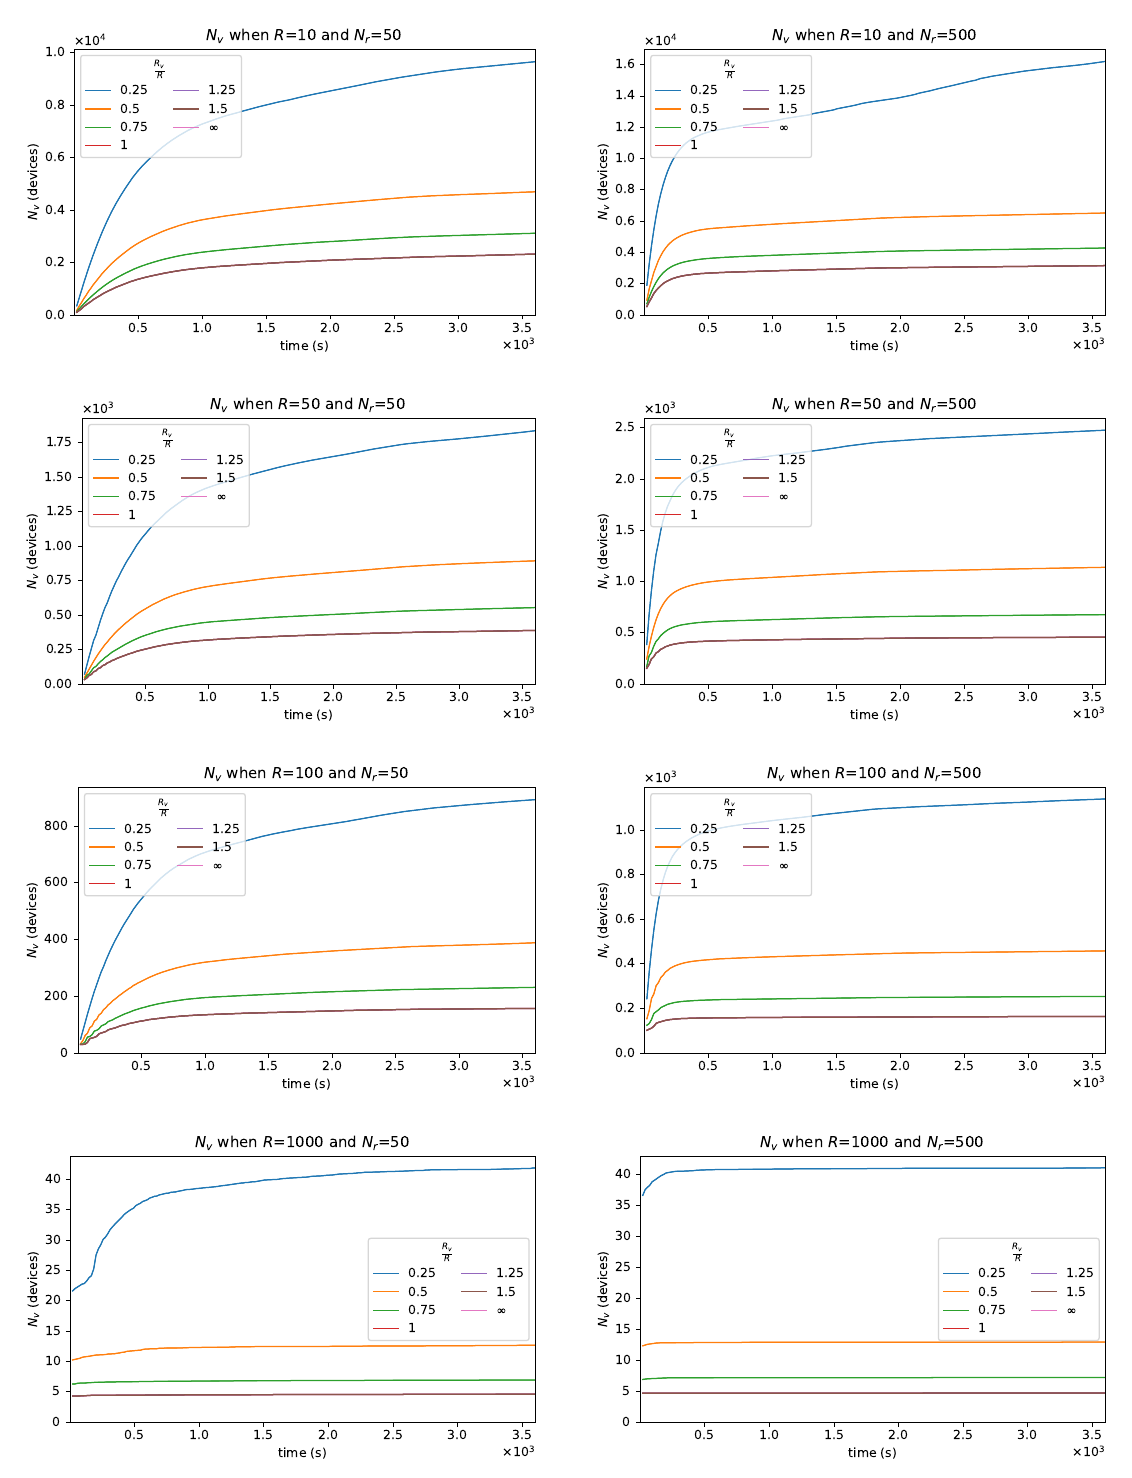
Figure 8. System cost in computational resources, using the count of virtual devices N v as a proxy metric, for 50 explorers ( left column ) and 500 explorers ( right column ), and increasing logical communication range R ( top to bottom ). The system cost grows more than linearly with shorter R v values. Considering the performance seen in Figures 6 and 7, it is clear that the value of N v needs to be selected carefully, as values too small do not improve performance substantially, but increase the computation cost